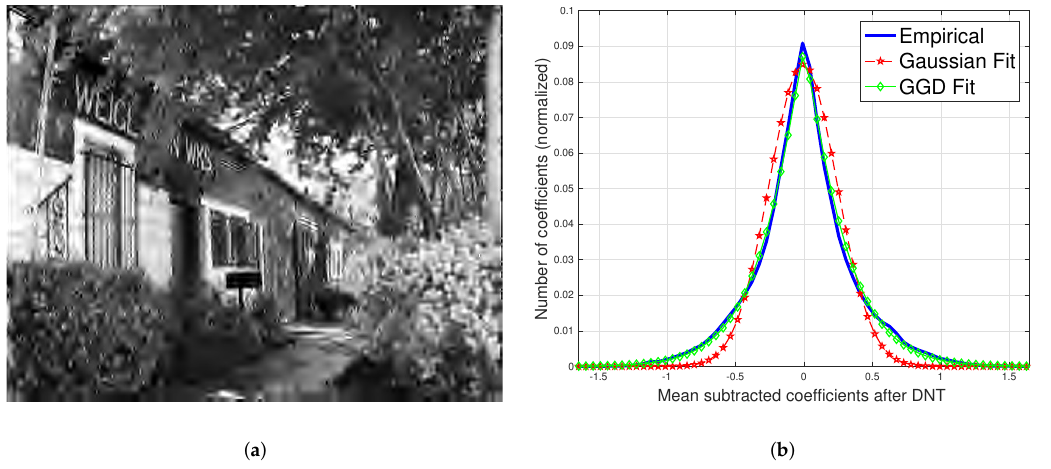
Figure 1. ( a ) JP2K compressed image and ( b ) its histogram of divisively normalized bandpass coefficients. The difference between the best generalized Gaussian distribution (GGD) and Gaussian fits indicates that the generalized Gaussian-based contrast estimator is more appropriate for distorted coefficients. The computed Kullback–Leibler divergence values of the Gaussian and GGD fits were found to be KLD gauss = 0.083 and KLD GGD = 0.005,